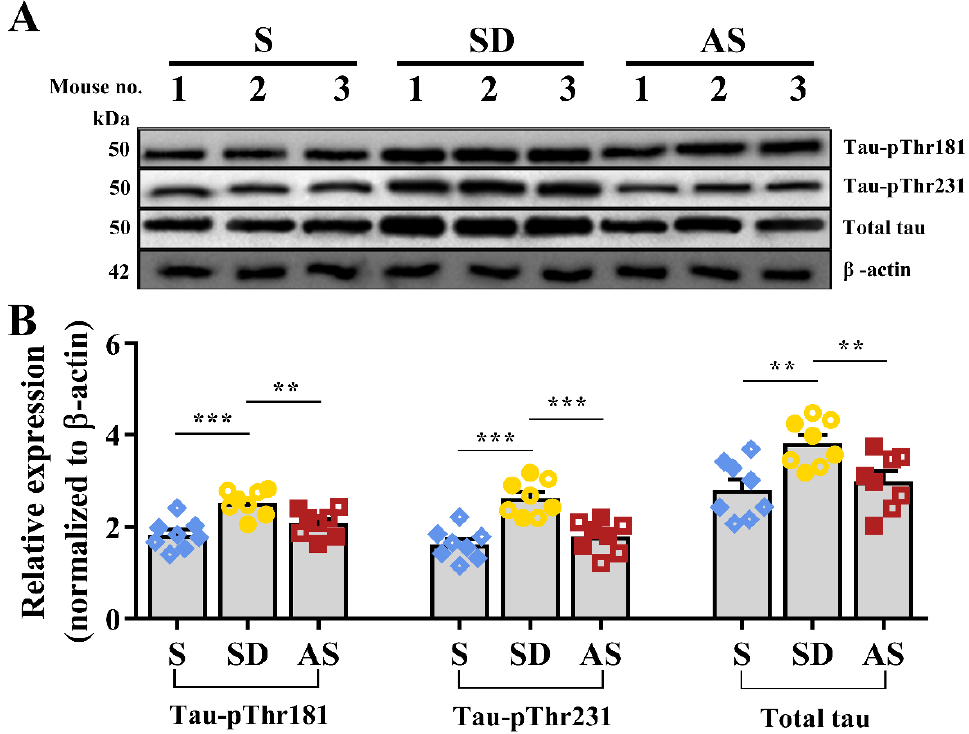
Figure 6. Acoustic stimulation inhibited tau pathology. ( A ) Representative images of Western blot. ( B ) The quantitative values of tau proteins. One-way ANOVA followed by two-sample LSD t tests is used. Data are expressed as mean ± SEM. Closed dots constitute male mice, and open dots constitute female mice. ** p < 0.01, *** p < 0.001.